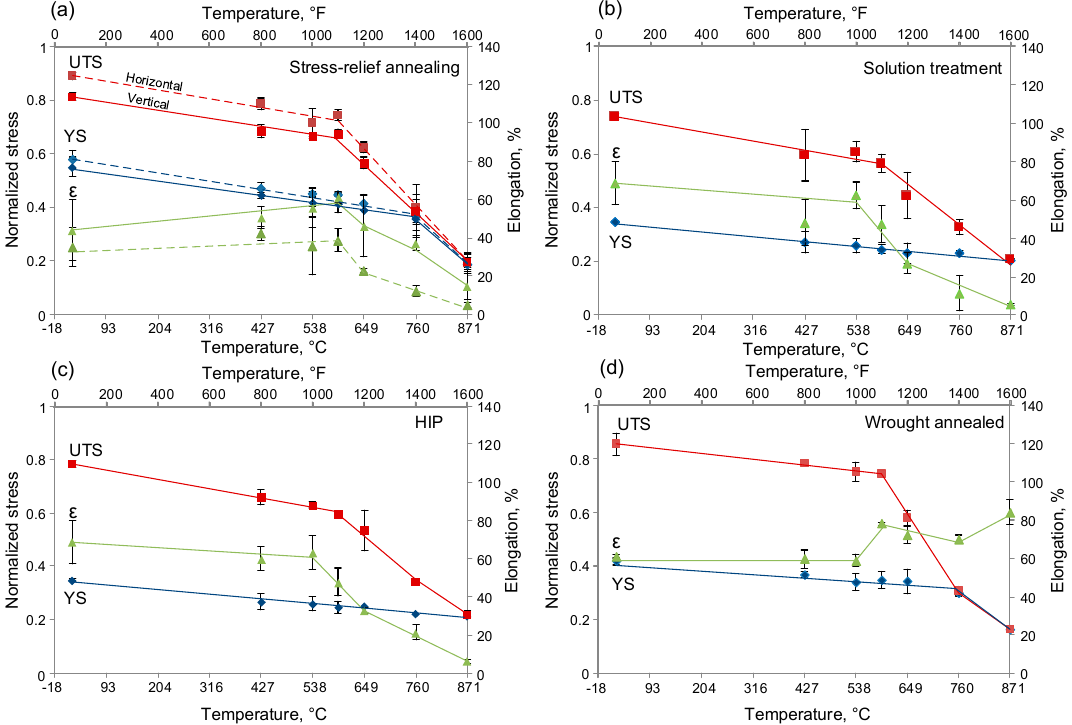
Figure 10. Mechanical properties of the ( a ) SR, ( b ) ST, ( c ) HIP, and ( d ) wrought annealed IN625 alloys as a function of temperature.